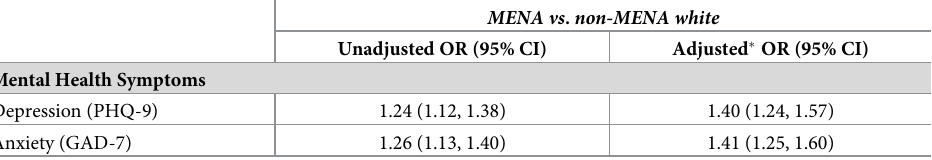
Table 2. Results of unadjusted and adjusted logistic regression for depression and anxiety in the Healthy Minds Study sample comparing Arab/Middle Eastern American (MENA) college students to non-MENA white college